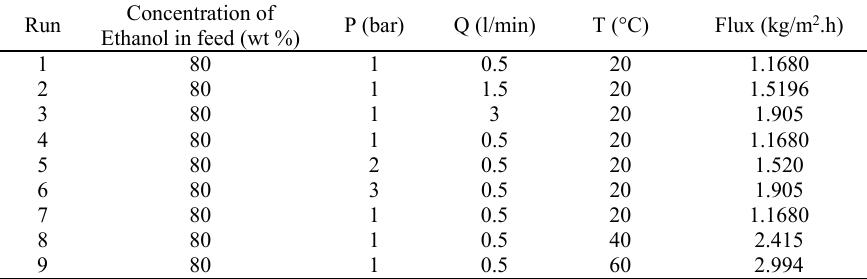
Table 3 Cross flow results by zeolite membrane Table 3: Cross flow results by zeolite Concentration of Run